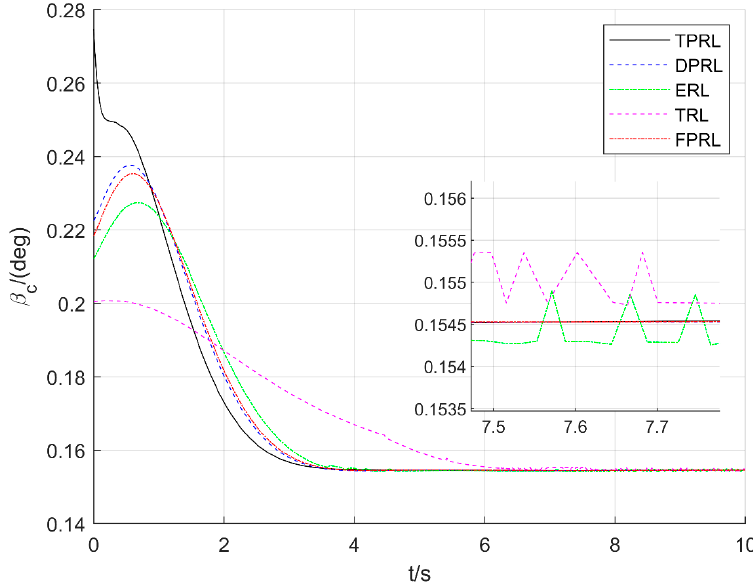
Figure 5. Controller output 𝛽 (cid:3030) under reaching laws.